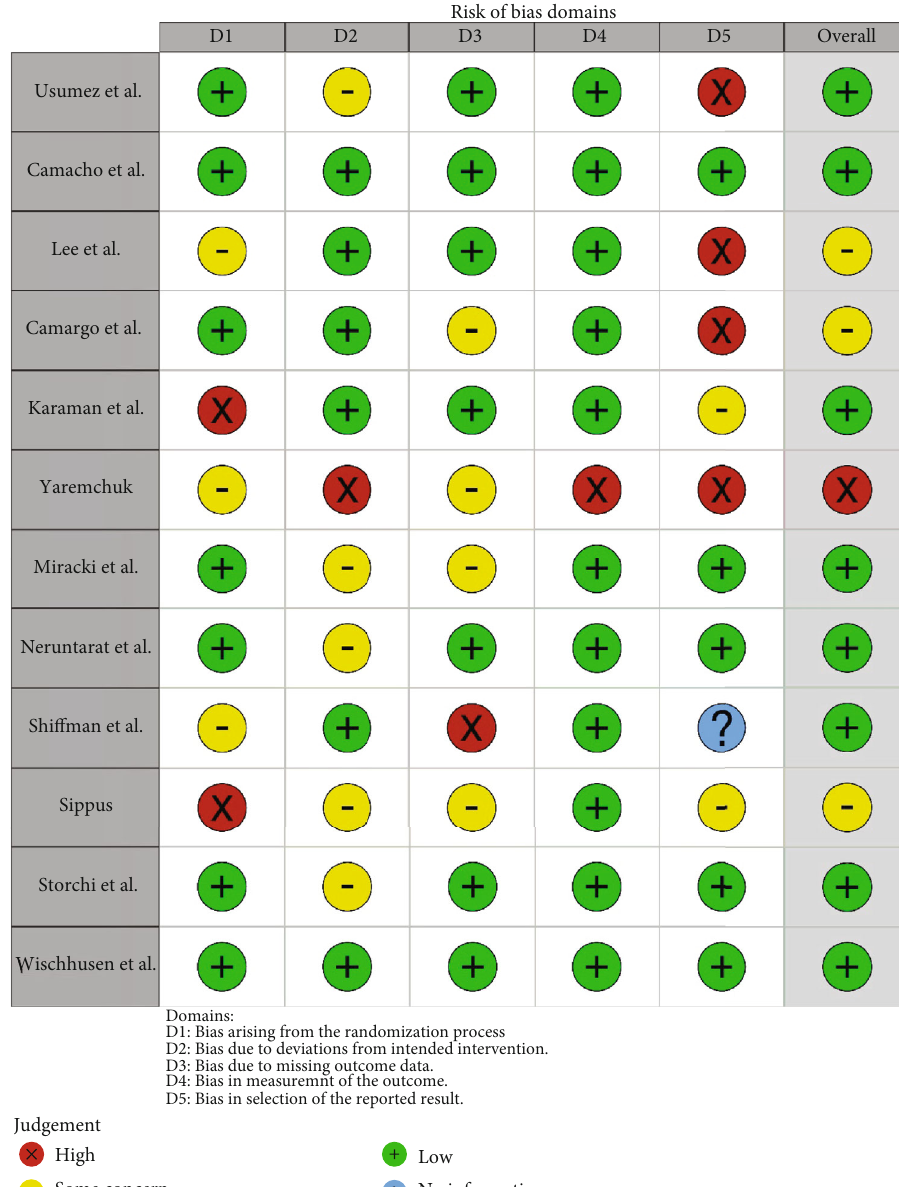
Figure 1: Risk of